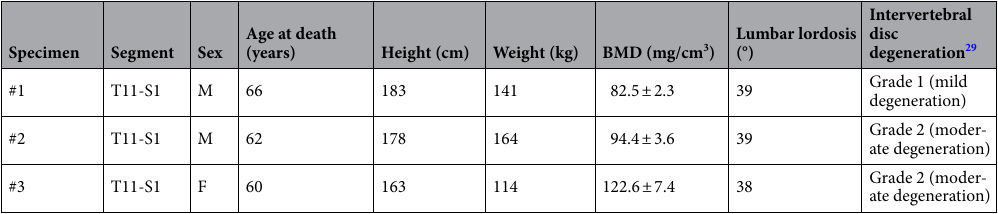
Table 1. Specimen data.